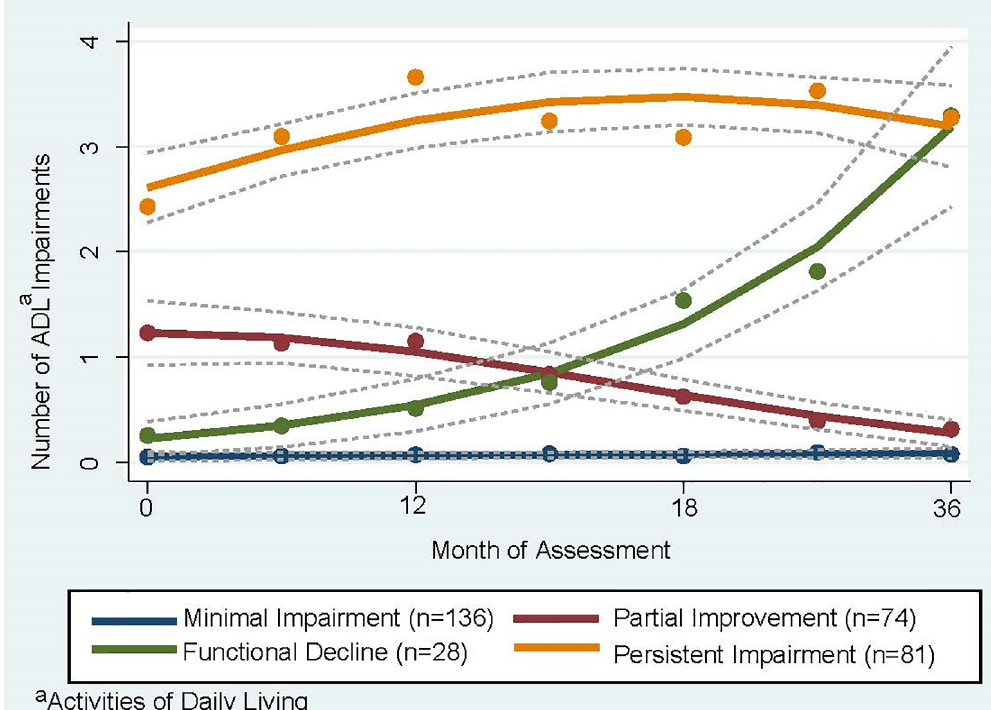
Fig 2. Functional trajectories among homeless older persons over the course of three-year follow-up. We used trajectory modeling to identify three-year functional trajectories based on participants’ self-reported ability to perform 5 basic activities of daily living (ADLs). We considered participants who died over follow-up to have difficulty in all 5 activities of daily living from the date of death. Number of ADL difficulties are portrayed on the y-axis, with month of assessment on the x-axis. Dotted lines indicate 95% confidence intervals for each